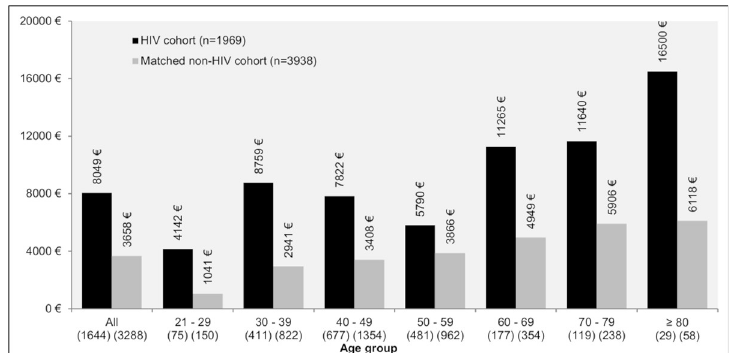
Fig 4. Mean total cost excluding ART in PLHIV and a matched non-HIV cohort over the previous 12 months, overall and stratified by age